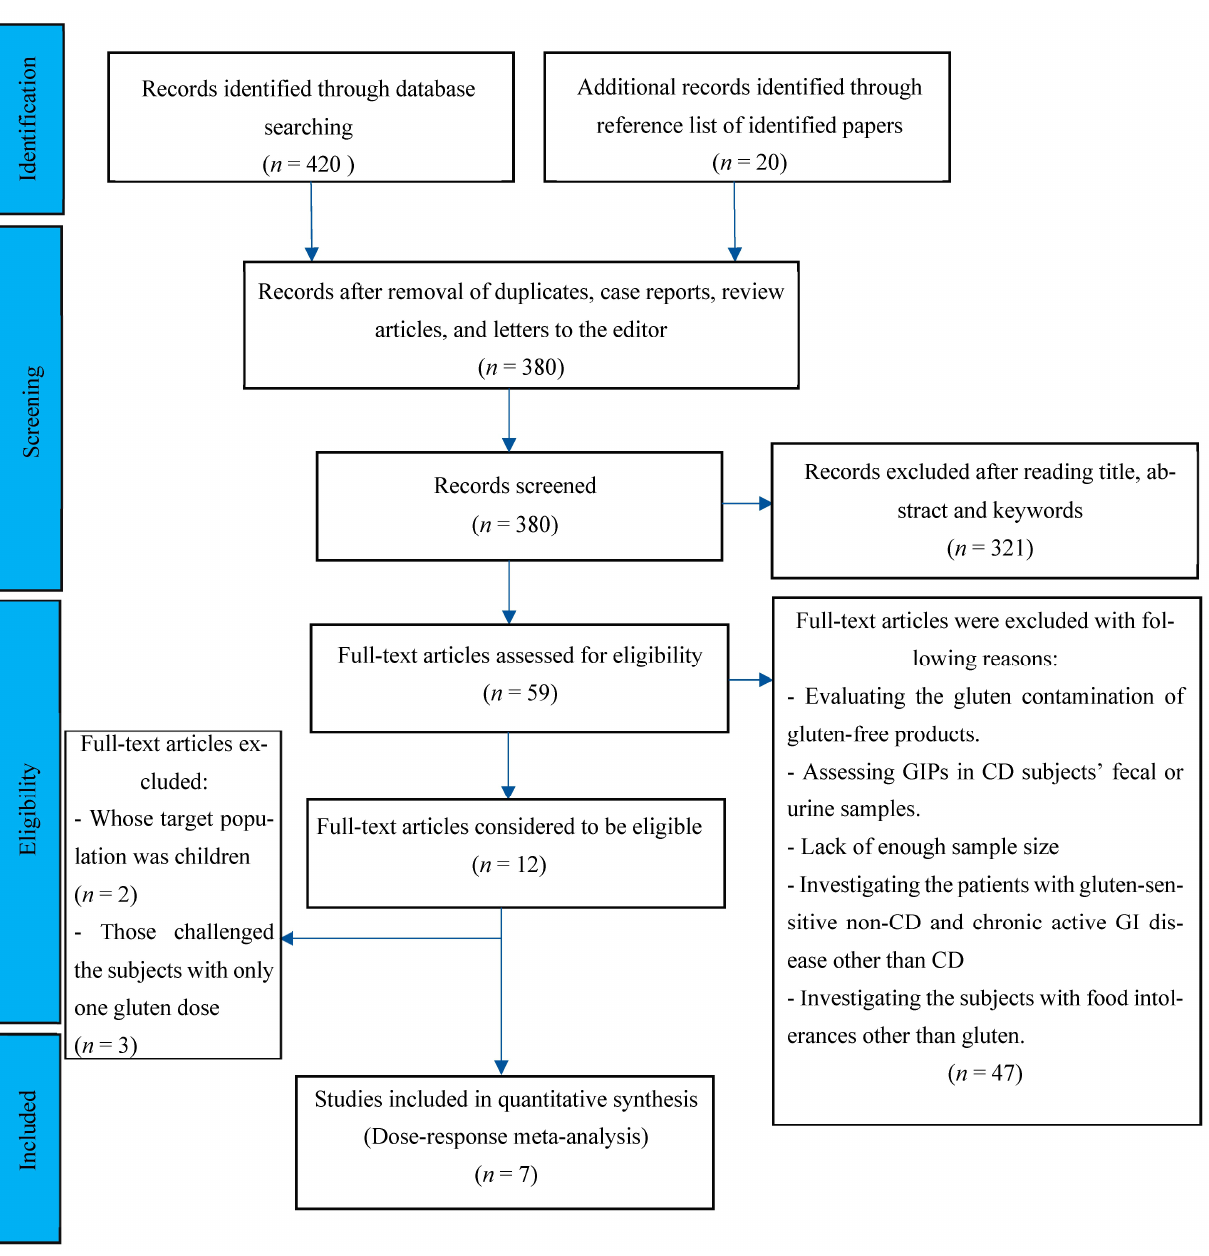
Figure 1. Flow chart showing the basis for selecting the studies used in the present analysis.